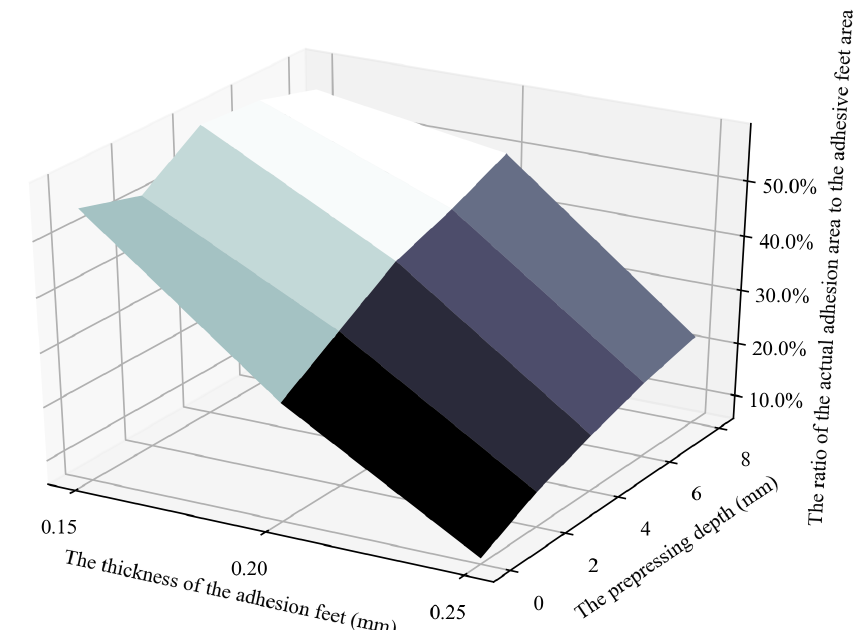
Figure A2. The actual adhesion ratio under different adhesion